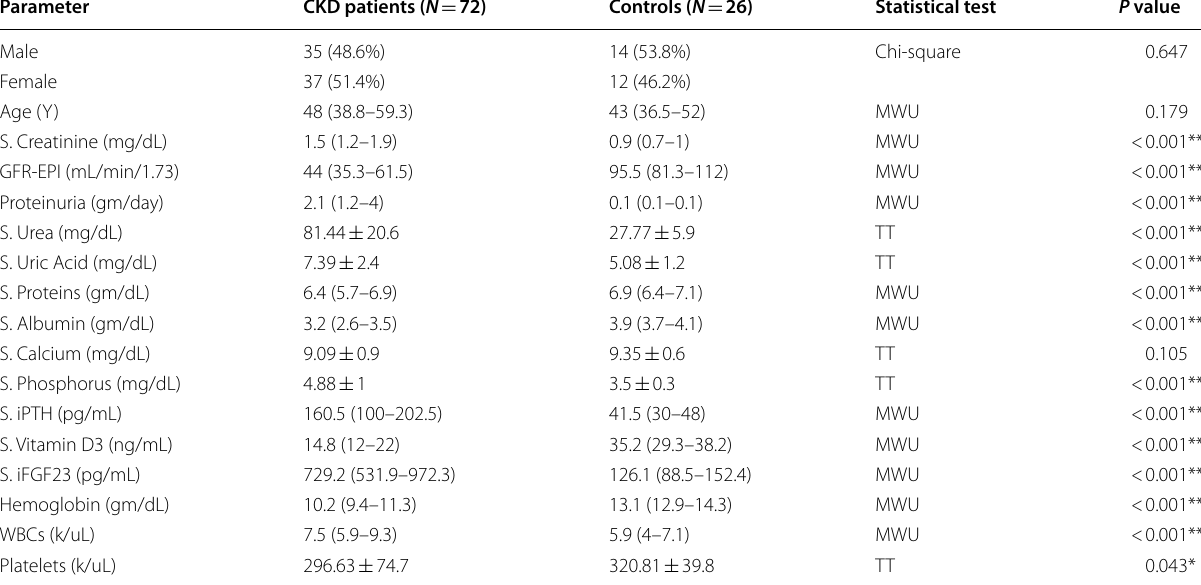
Table 1 Characteristics of the study